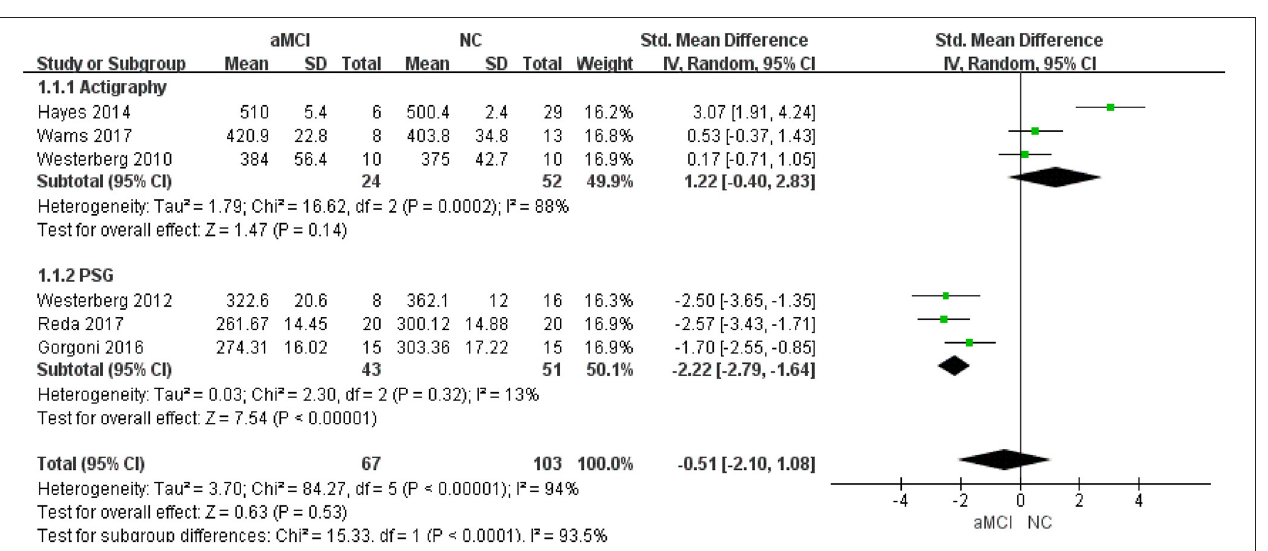
FIGURE 3 | Subgroup analysis of different measurements in relation to TST.